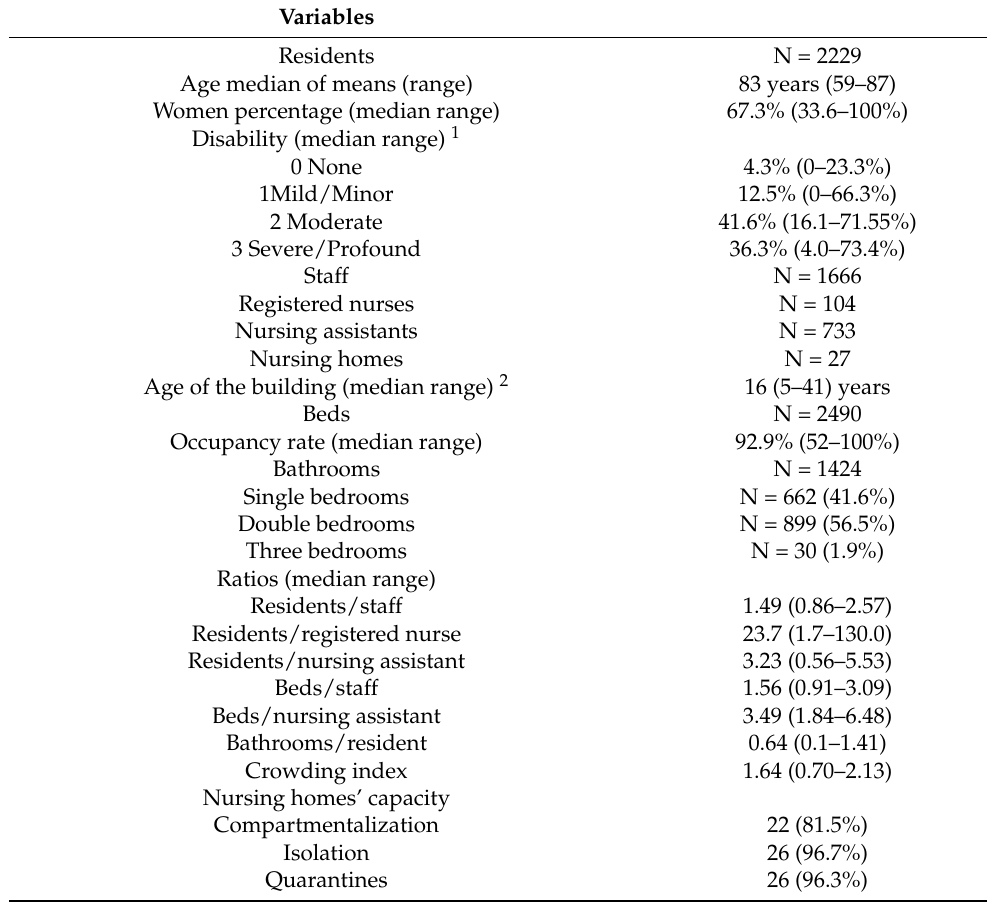
Table 1. Characteristics of 27 nursing homes (NHs). Health Departments 2 and 3 of Castellon.